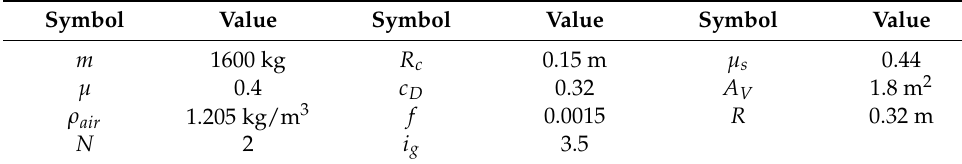
Table 2. Parameters used in real-time modeling 25 .